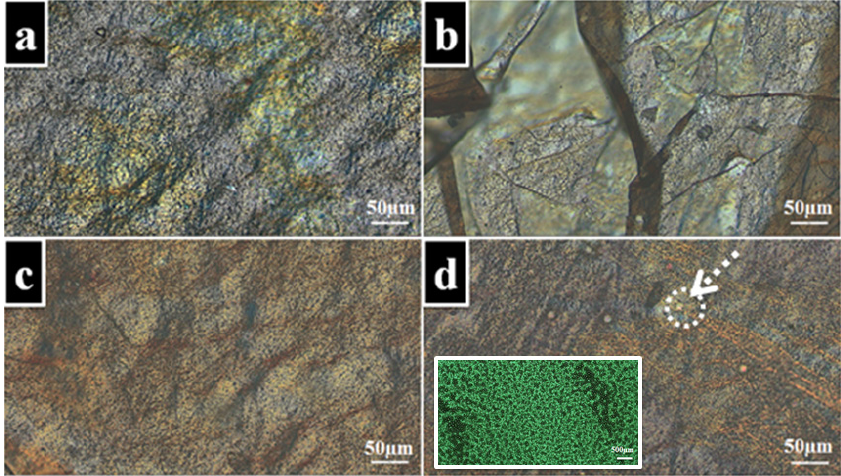
Figure 4. Optical microscope images of electrospun membranes PVA ( a ), PVA– Thymus vulgaris ( b ), PVA– Salvia officinalis folium ( c ), PVA– Hyperici herba ( d ), and Hyperici herba hydroalcoholic extract (d inset).